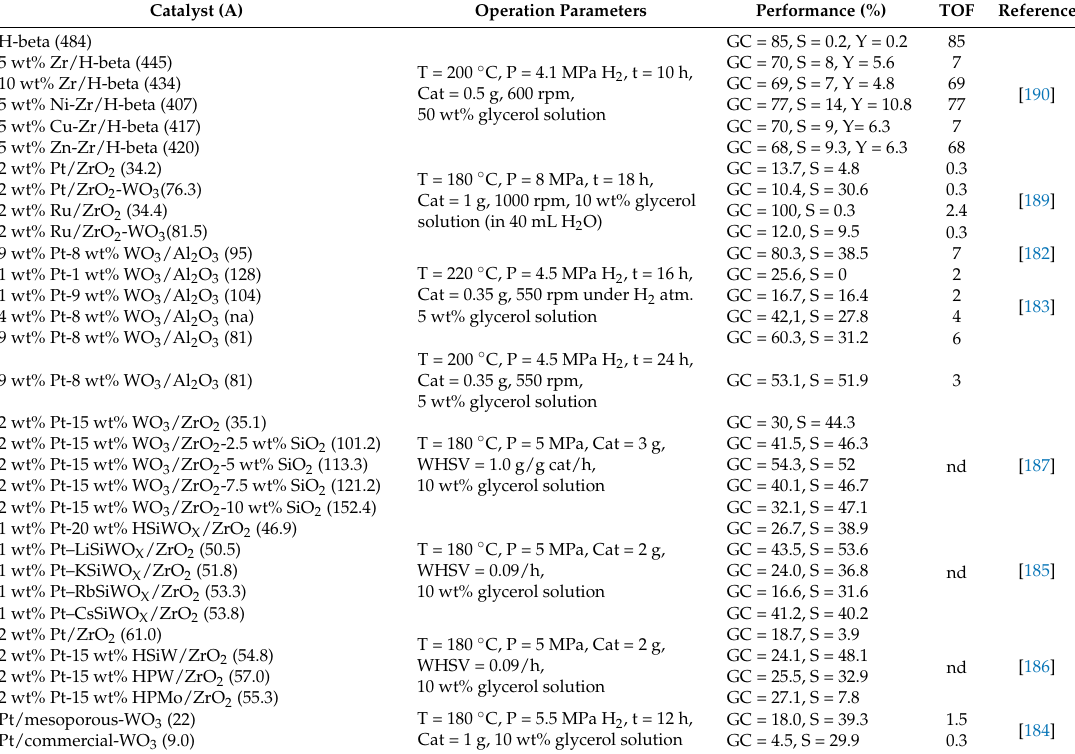
Table 13. Performance of some catalysts in the conversion of glycerol to 1,3-Propanediol as reported in some